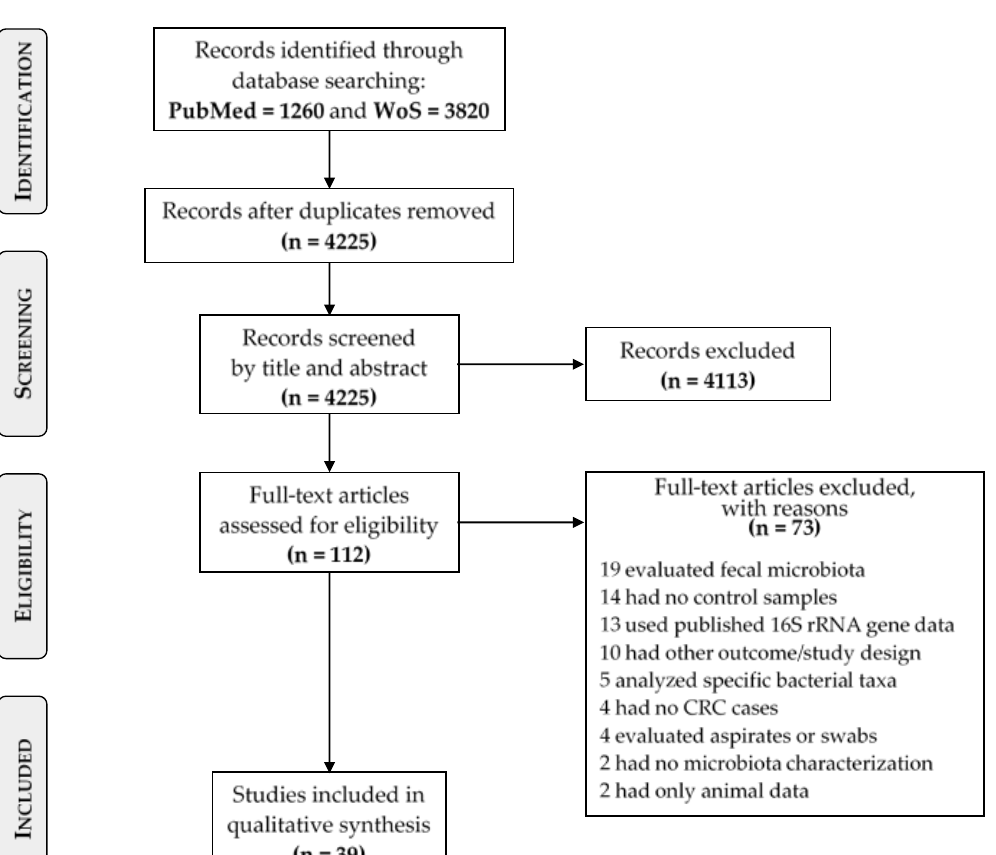
Figure 1. PRISMA flow-chart of the study selection process.